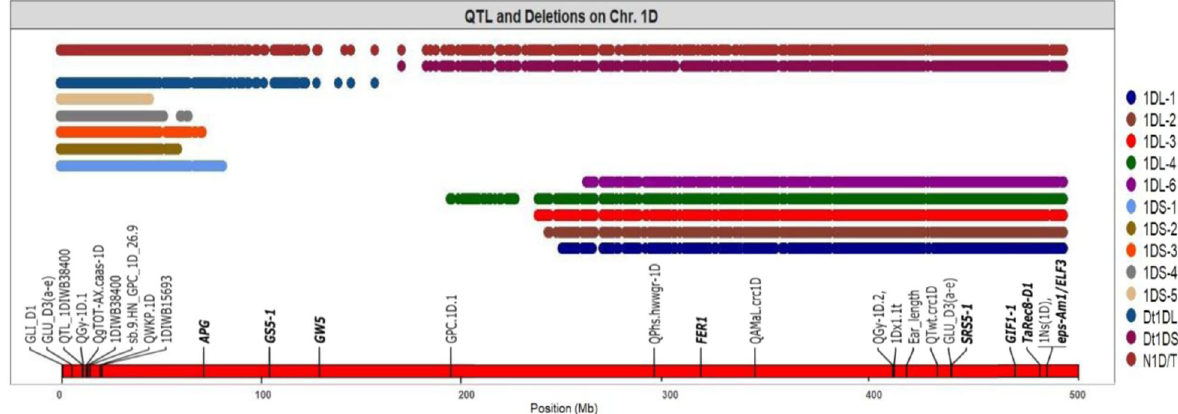
Fig. 5 Physical mapping of chromosomal and/or segmental deletion in lines at 1D chromosome. Dots denote the deletion position in the mutants according to GBS reads within 1 Mb in a euploid CS. QTL and genes were physically mapped using IWGSC Ref Seq v1.1 wheat genome assembly 8